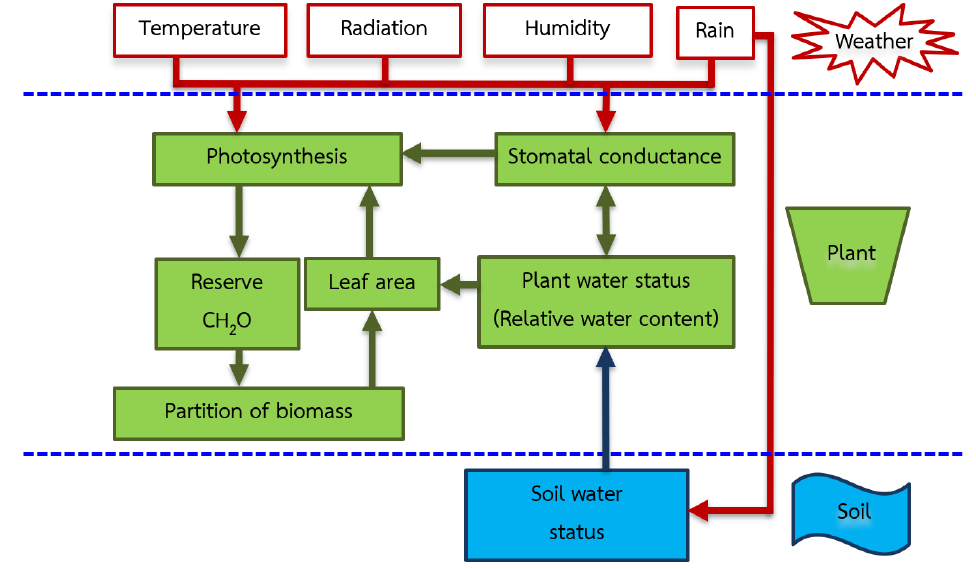
Figure 2. Conceptual framework concerning climatic factors, soil moisture content and cassava